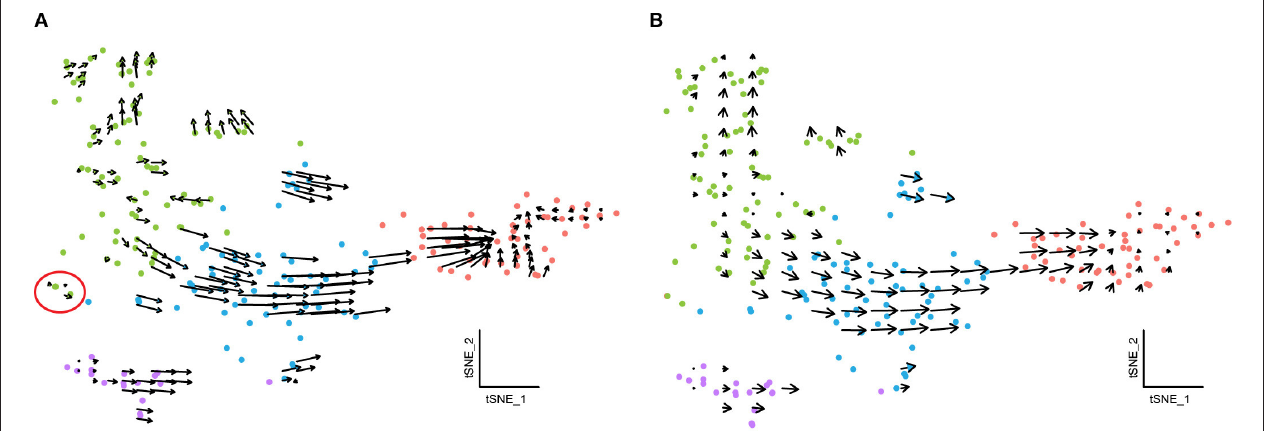
FIGURE 7 | RNA velocity plotted in t-SNE space for neural cell types. (A) Velocyto force field showing the average differentiation trajectories (velocity) for cells located in different parts of the tSNE plot. For each cell, arrows indicate the location of the future cell state. RNA dynamics vary between NPCs, the two differentiation trajectories and mature neurons and also within each cell type. Velocity estimates based on nearest cell pooling ( k = 5) were used. Red circle shows two cells with velocity fields pointing along the two differentiation trajectories possibly representing a progenitor population for neural and neurosecretory cells, respectively. (B) Same velocity field as A, visualized using Gaussian smoothing on a regular